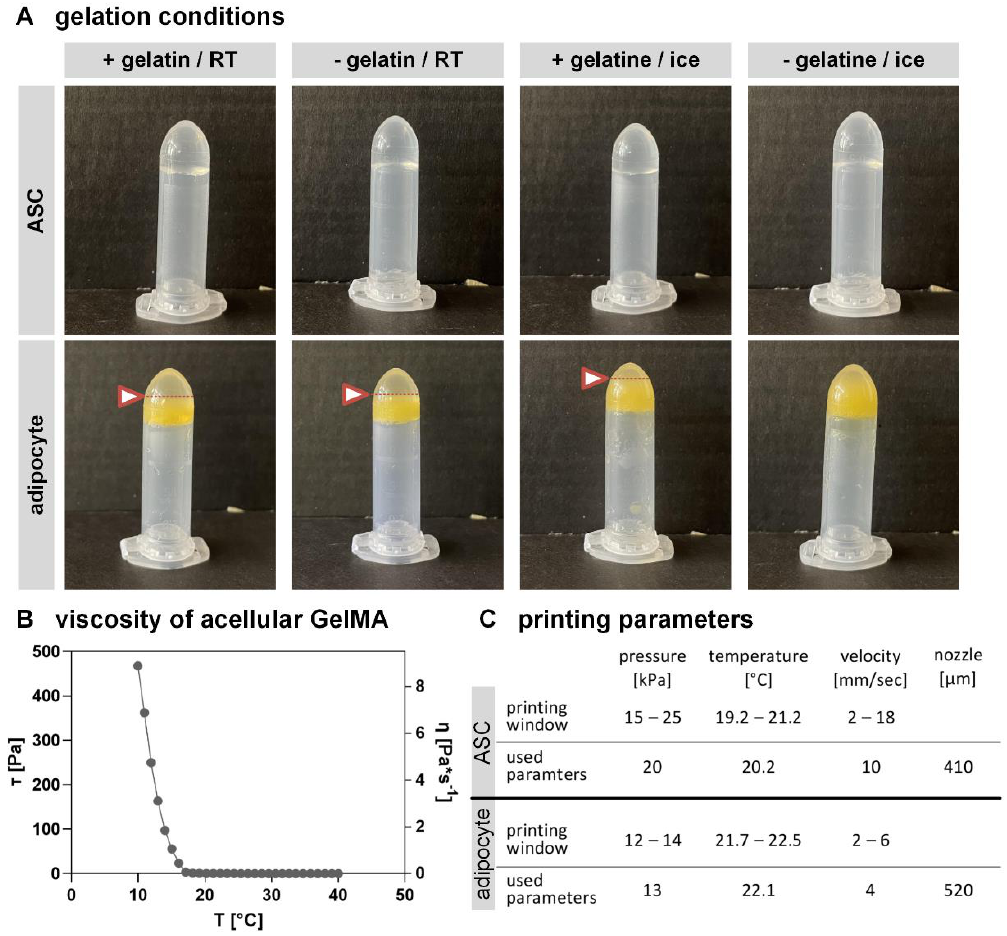
Figure 4. GelMA characteristics and gelation behavior and bioprinting parameters of cell-containing GelMA. ( A ) depicts GelMA containing ASCs or mature adipocytes with (+) and without ( − ) unmodi- fied gelatin with induced gelation at room temperature (RT) or on ice. Phase-separation indicated by the arrow with dotted line ( B ) Viscosity of acellular GelMA without unmodified gelatin ( C ) listed bioprinting windows and used parameters for ASC or adipocyte-containing GelMA